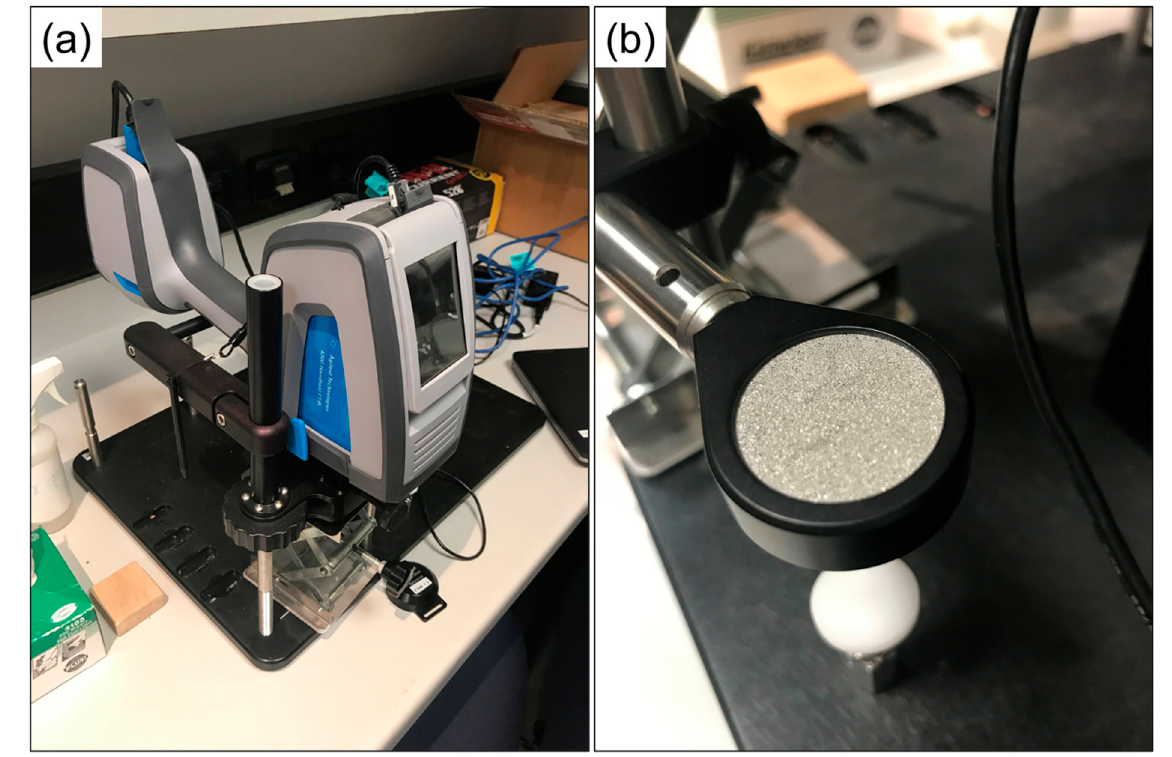
Figure A13. ( a ) The setup at CSIRO using the handheld Agilent 4300 FTIR with ( b ) the coarse silver reference target. With the Bruker 80v spectrometer, measurements on Sample 1 and Sample 2 were collected with both the bottom port and top port for comparison. Due to the size of the laminate of the samples, it was required to hold them flat against the top port to clear the surrounding hardware (Teflon gasket between the entrance port) as shown in Figure A14.